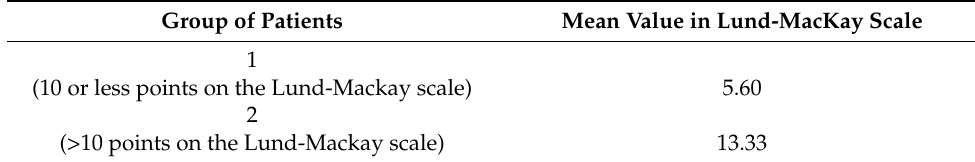
Table 1. Mean value in Lund-MacKay scale in group 1 and 2.